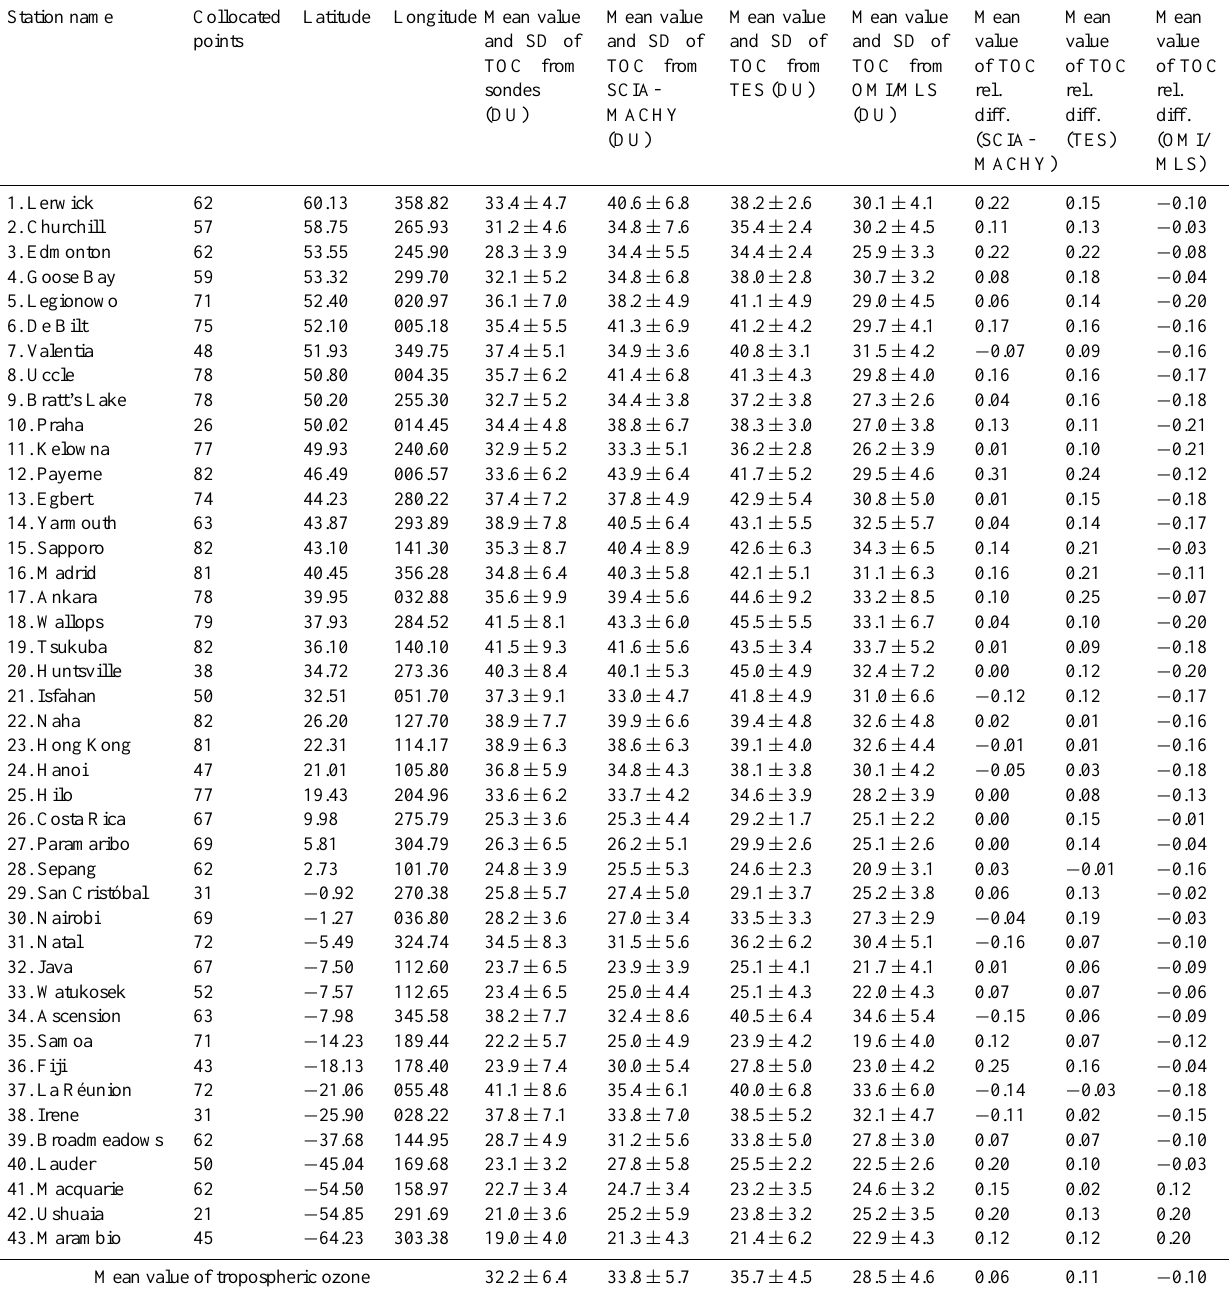
Table 3. Comparisons of tropospheric ozone columns from SCIAMACHY, ozonesondes, TES and OMI/MLS for some selected stations over the entire time series (2004–2011). Mean value and standard deviation (SD) as well as the relative difference of each satellite data product using ozonesonde as the reference are